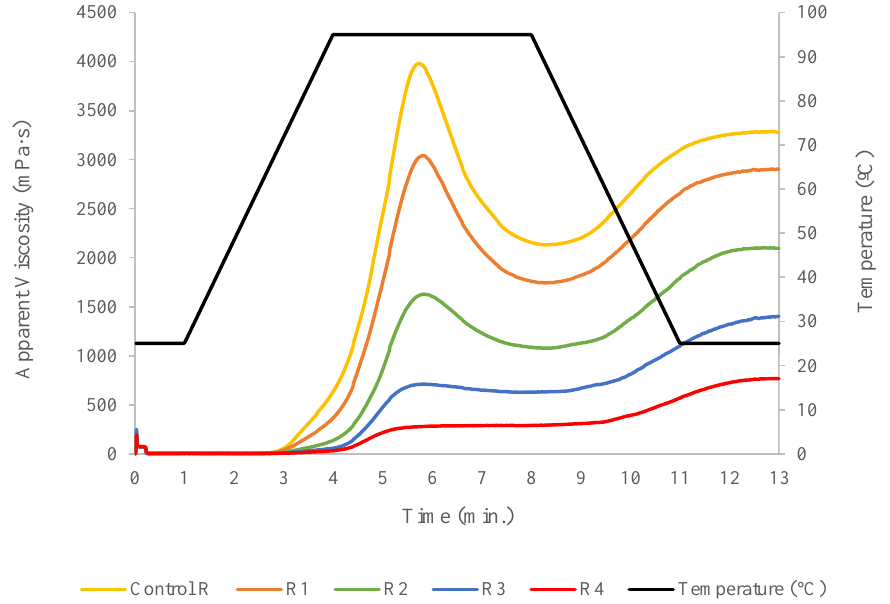
Figure 3. Rapid Visco Analyzer profiles of formulated unprocessed flours containing different concentration of tiger nut flour.